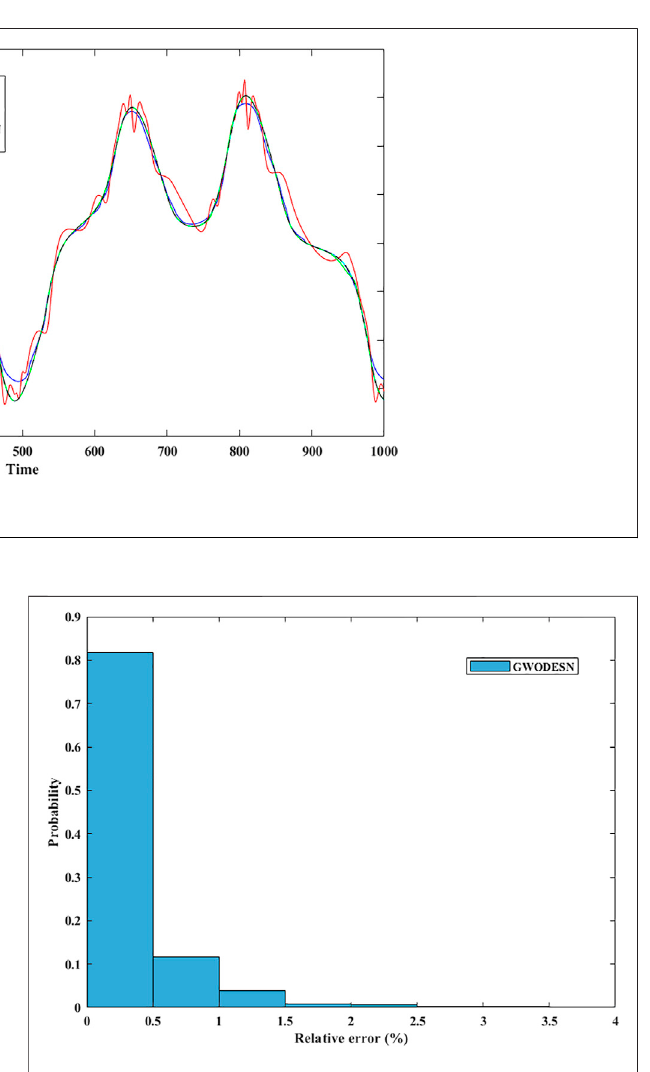
FIGURE 5 | Relative error distribution for Lorenz x( t